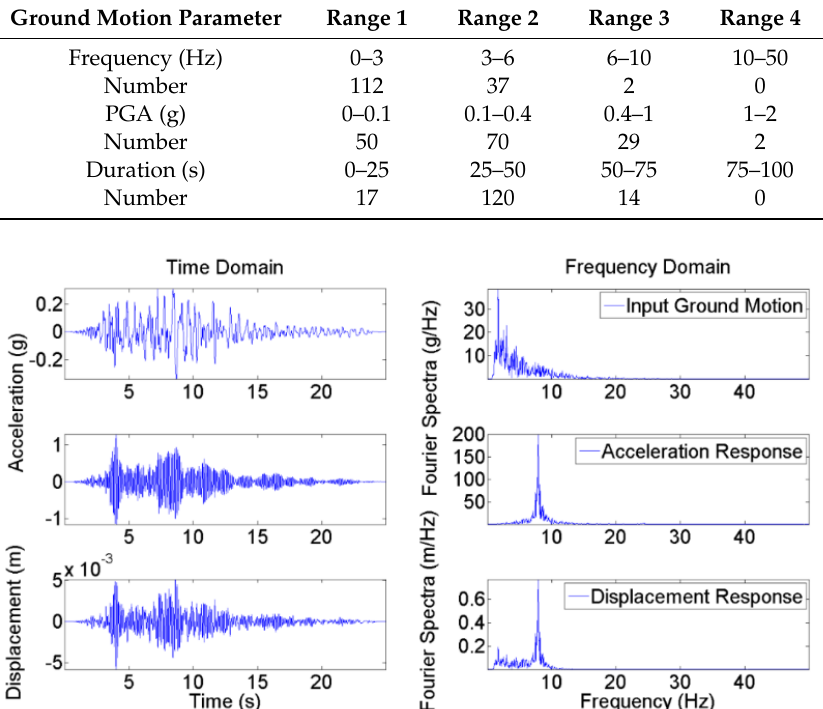
Table 2. Ground motion dataset summary.